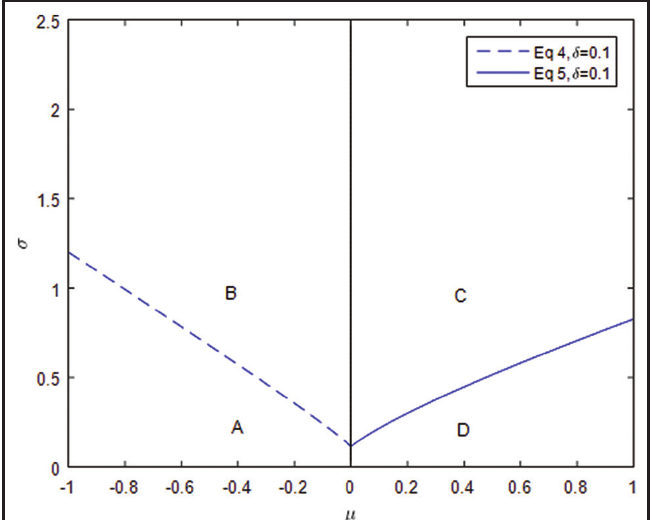
Figure 1 Theoretical prediction of trial period policy impact on whether to